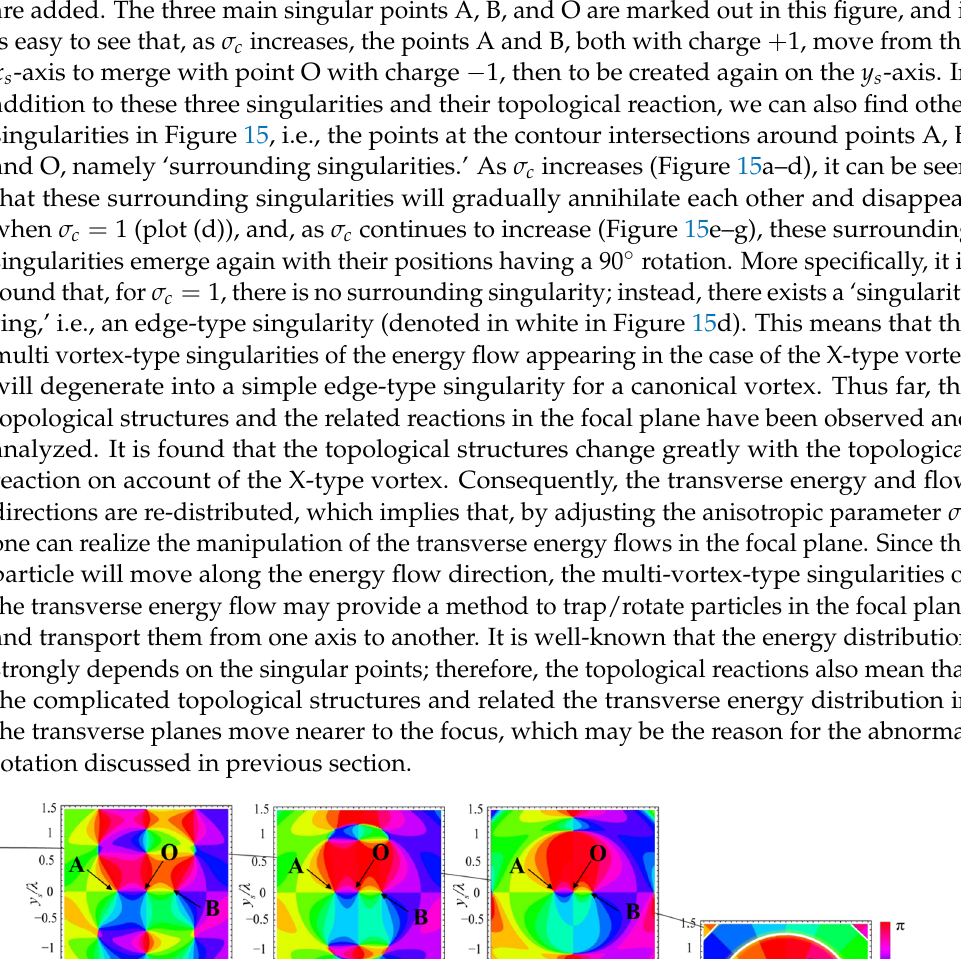
Figure 15. Contours of the phase of complex transverse Poynting field, arg [𝑝 (cid:3051)(cid:3052)((cid:3030)) ] on the focal plane for 𝑙 = 2 : ( a ) 𝜎 (cid:3030) = 0.1 ; ( b ) 𝜎 (cid:3030) = 0.3 ; ( c ) 𝜎 (cid:3030) = 0. ;, ( d ) 𝜎 (cid:3030) = 1 ; ( e ) 𝜎 (cid:3030) = 2 ; ( f ) 𝜎 (cid:3030) = 3 ; ( g ) 𝜎 (cid:3030) = 10 .